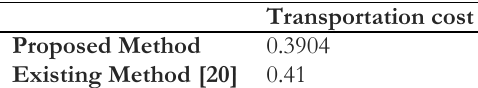
Table 14. Comparison of proposed method with existing method of example